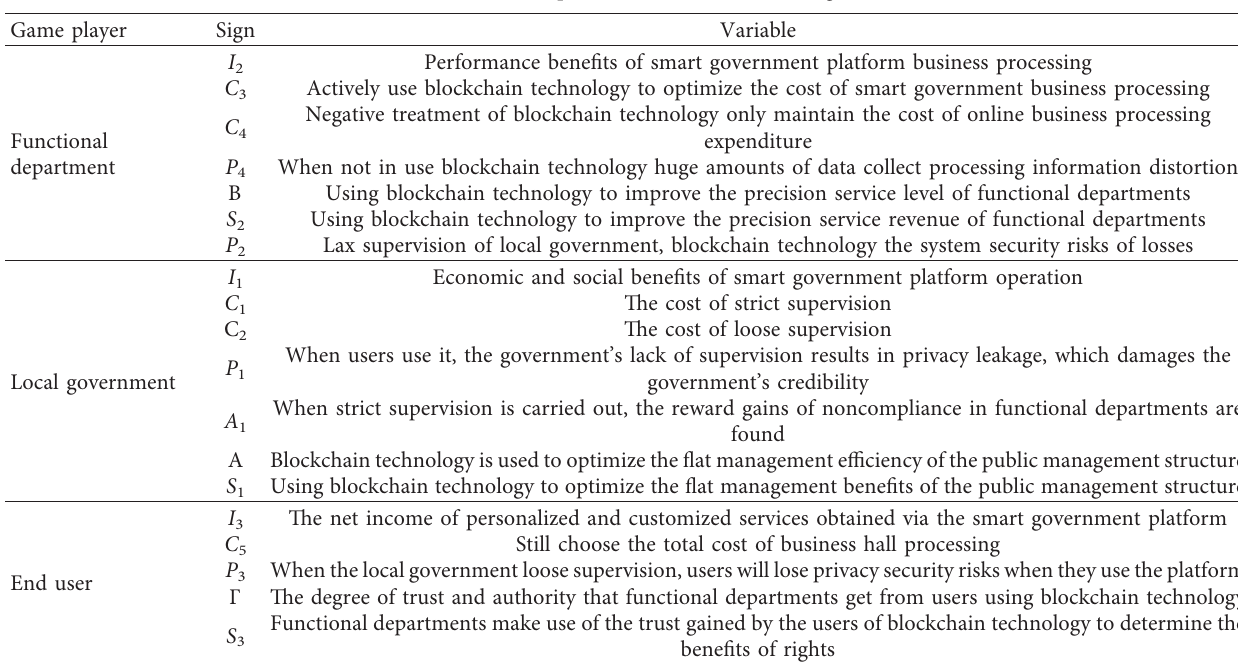
Table 1: Main parameters and their meaning.